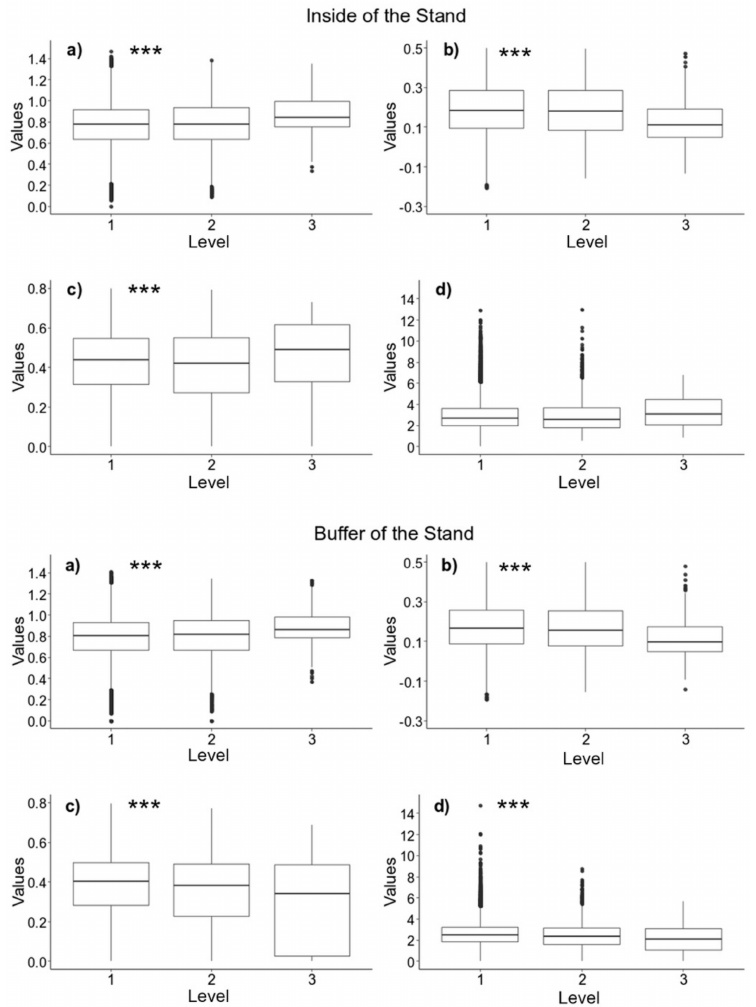
Figure 3. Mean values of ( a ) Moisture Stress Index (MSI), ( b ) Normalized Di ff erence Infrared Index (NDII), ( c ) Normalized Di ff erence Vegetation Index (NDVI) and ( d ) Ratio Vegetation Index (RVI) according to defoliation grades of a processionary moth for the stand bu ff er area (upper) and inside stand area (lower). (*** p -value <